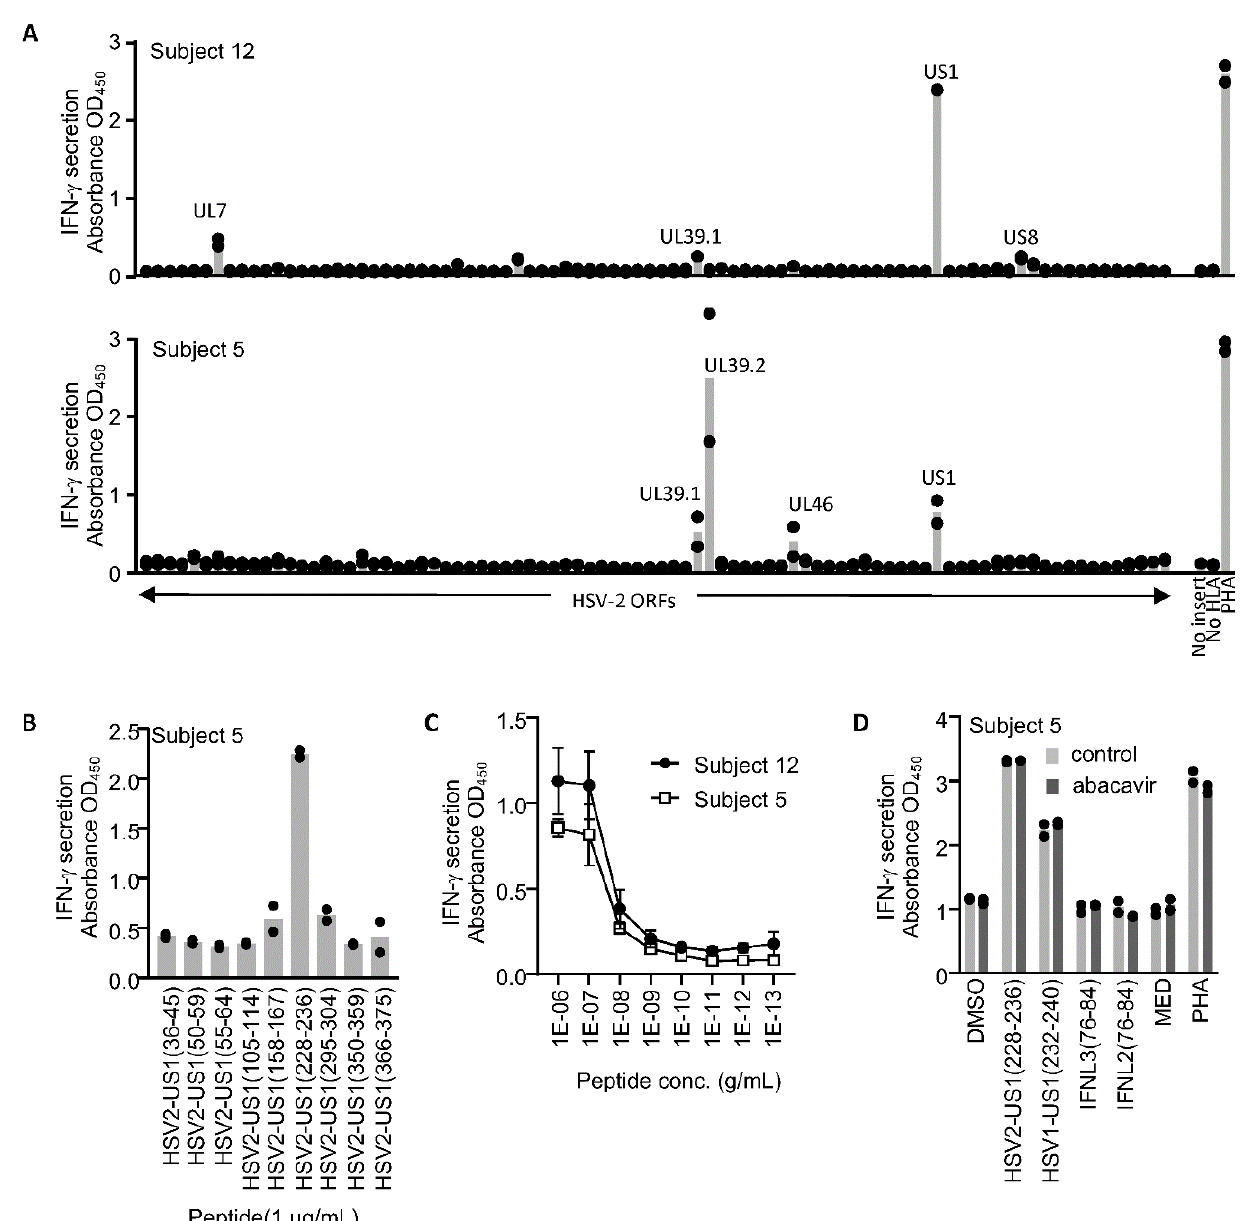
Figure 1. ( A ) T-cell lines generated from CD8 T cells activated (CD137 high ) following exposure to HSV-2 cross-presented antigen were screened for their protein specificity. An expression library representing all HSV-2 ORFs was co-transfected with HLA-B*57:01 into COS-7 cells to generate artificial antigen-presenting cells (aAPC). HSV-2-specific CD8 T-cell lines were exposed to aAPC and activation measured by IFN- γ secretion. HSV-2 ORFs that generated responses are labeled. ( B ) An epitope at HSV-2 ICP22 (ORF US1) aa 228–236 (sequence RTRLGPRTW; abbreviated RTR) was detected by testing predicted HLA-B*57:01 binding peptides. ( C ) RTR peptide was active to 10 ng/mL for T-cell lines from both subjects. ( D ) Exposure to abacavir (10 µ g/mL) did not alter the recognition of RTR or the homolog from HSV-1 (HSV1-US1 (232–240)), and did not reveal activation in the presence of peptides with similar sequences in human IFNL3 (76–84) RsRLfPRTW or IFNL2 (76–84) hsRLfPRTW. MED, medium alone; PHA, phytohemagluttinin P. Alternative amino acids are shown in lower case. All tests were performed in duplicate with raw data indicated and means shown as bars ( A , B , D ) or with means shown as symbols and standard deviations shown as error bars ( C ). Since HLA-B*57:01 is associated with hypersensitivity reactions to abacavir, we as- sessed whether abacavir has any impact on CD8 T-cell activation by RTR, or by sequence- similar peptides from HSV-1 or human interferon lambda (Table 1). We observed the